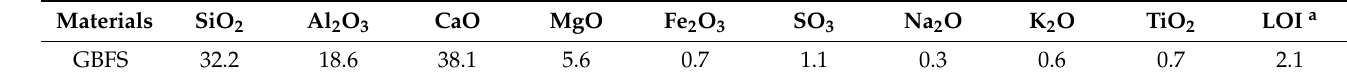
Table 2. Chemical compositions (wt%) of